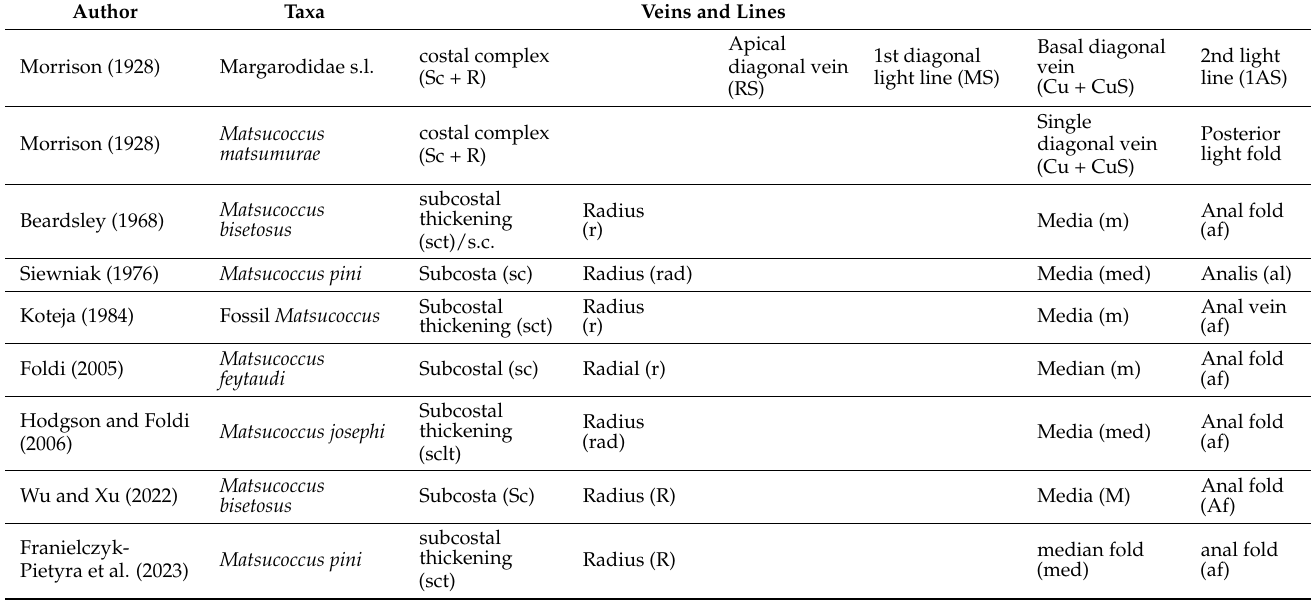
Table 1. Wing vein